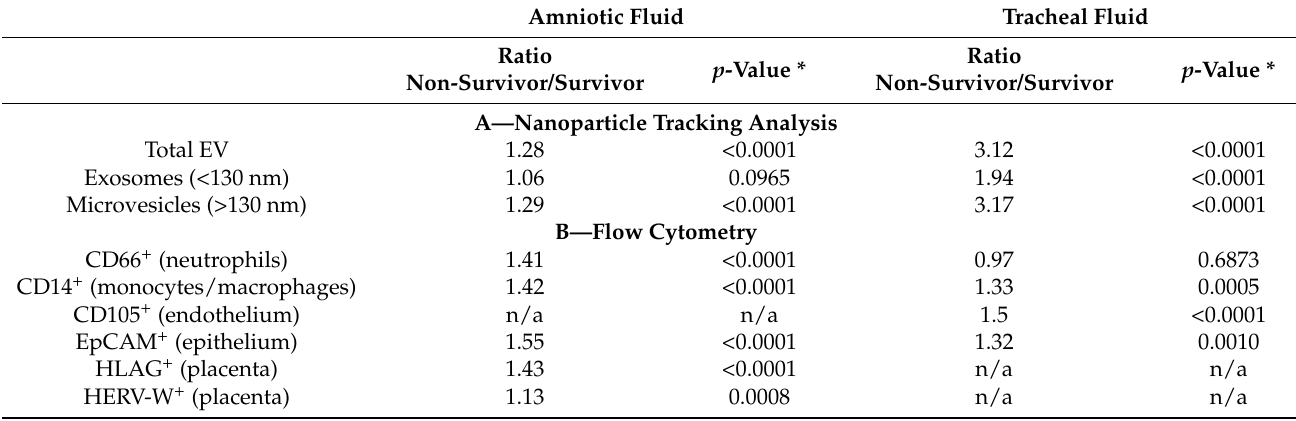
Table 2. Ratio of the mean EV count between survivors and not-survivors subjects. p -value is estimated by linear Poisson regression models, allowing for